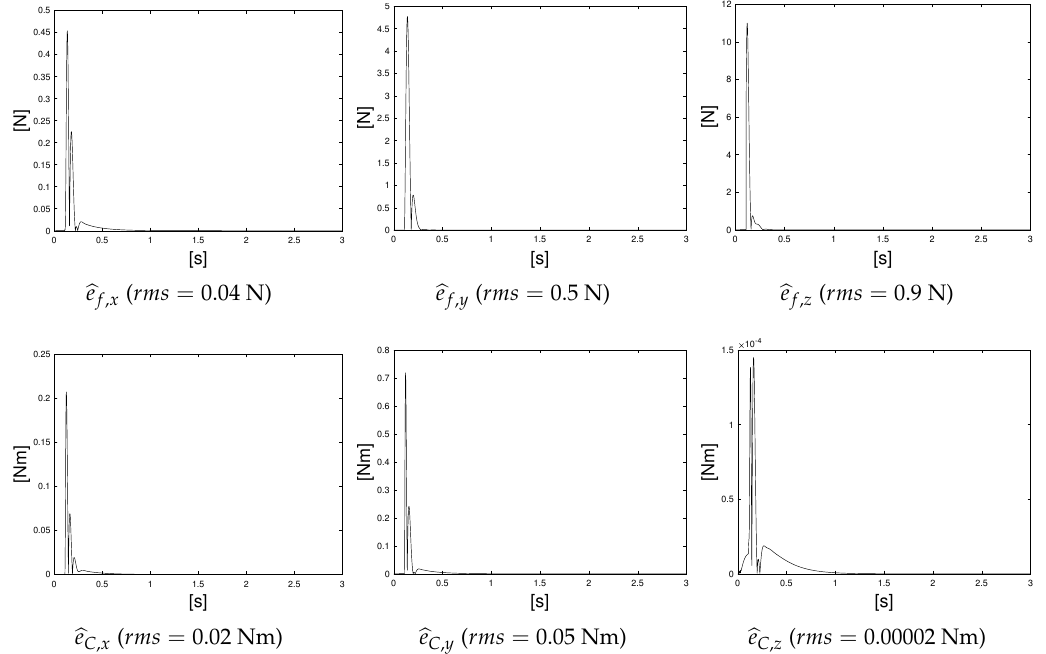
Figure 6. Estimated interaction forces (cid:98) e f and torques (cid:98) e C errors for the #3 simulation